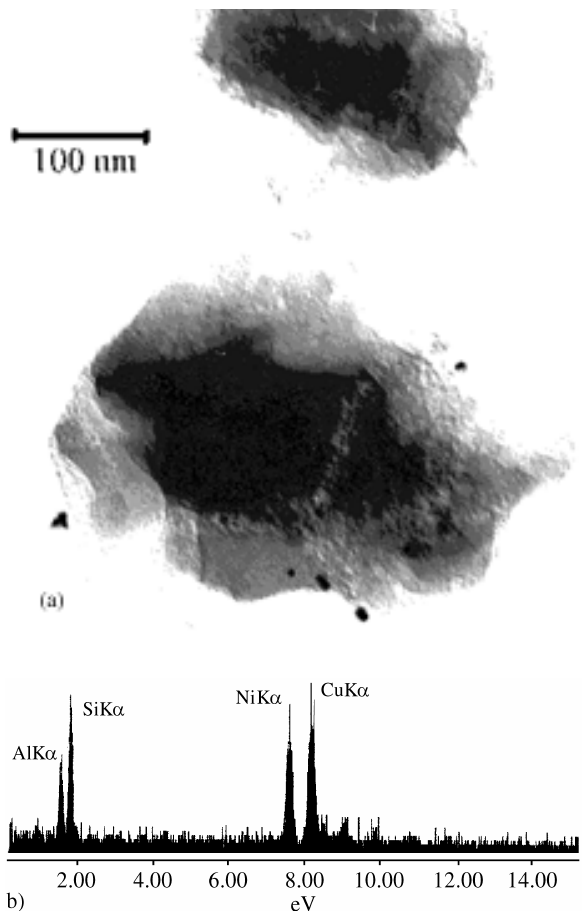
Figure 1. (a) TEM and (b) EDX analysis of 2% Ni/HUSY (sample A).